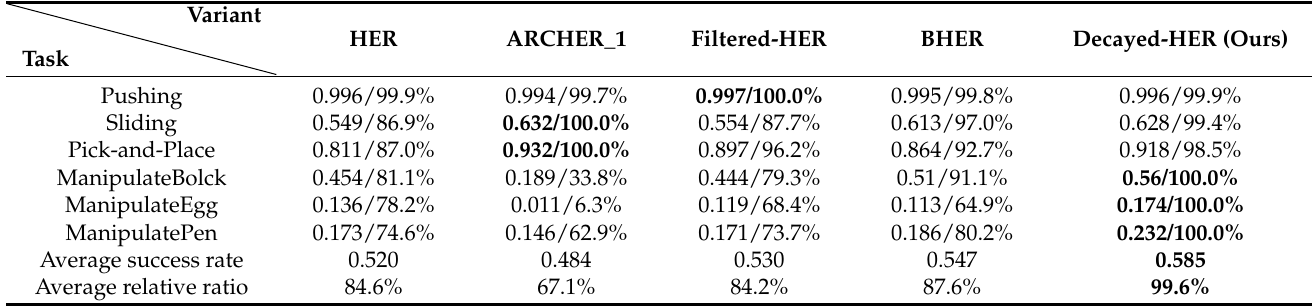
Table 4. Final mean success rates comparison. We list the final average success rate for each variant on each task and its ratio to the best achieved average success rate on the task.